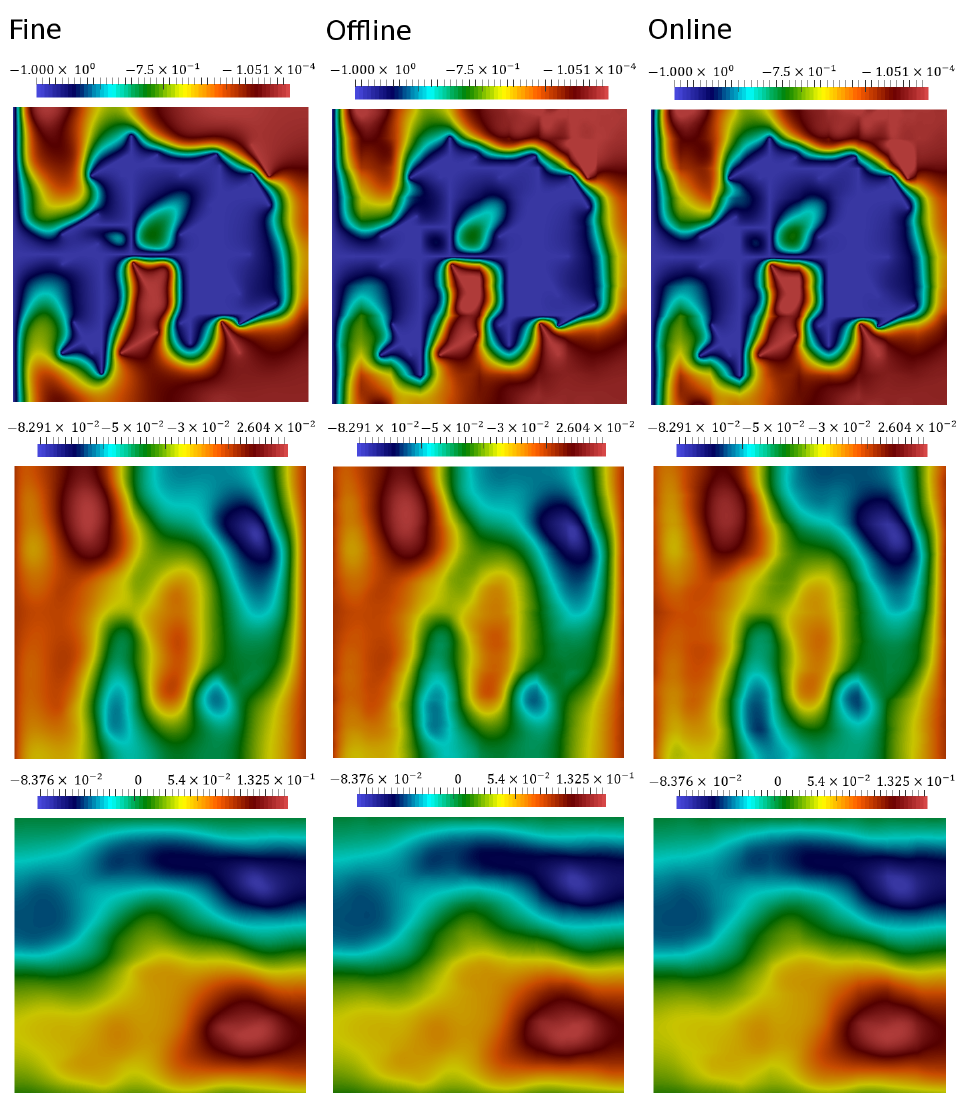
Figure 10. Case 2 . Fine-scale solution with DOF h = 12,944 ( left ), coarse-scale using 4 offline basis functions with DOF H = 1452 ( middle ), and coarse-scale with one online residual-based multiscale basis function with DOF H = 1815 ( right ) at the final time. ( Top ) Pressure. ( Center ) Displacement X direction. ( Bottom ) Displacement Y